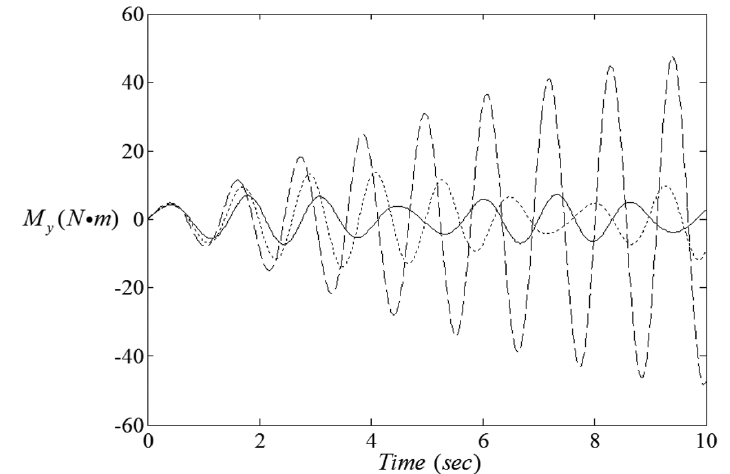
Fig. 9. The resultant hydrodynamic moment with the center of the bottom under the harmonic excitation for h 1 / R 2 = 0.3 and three different R 1 / R 2 (